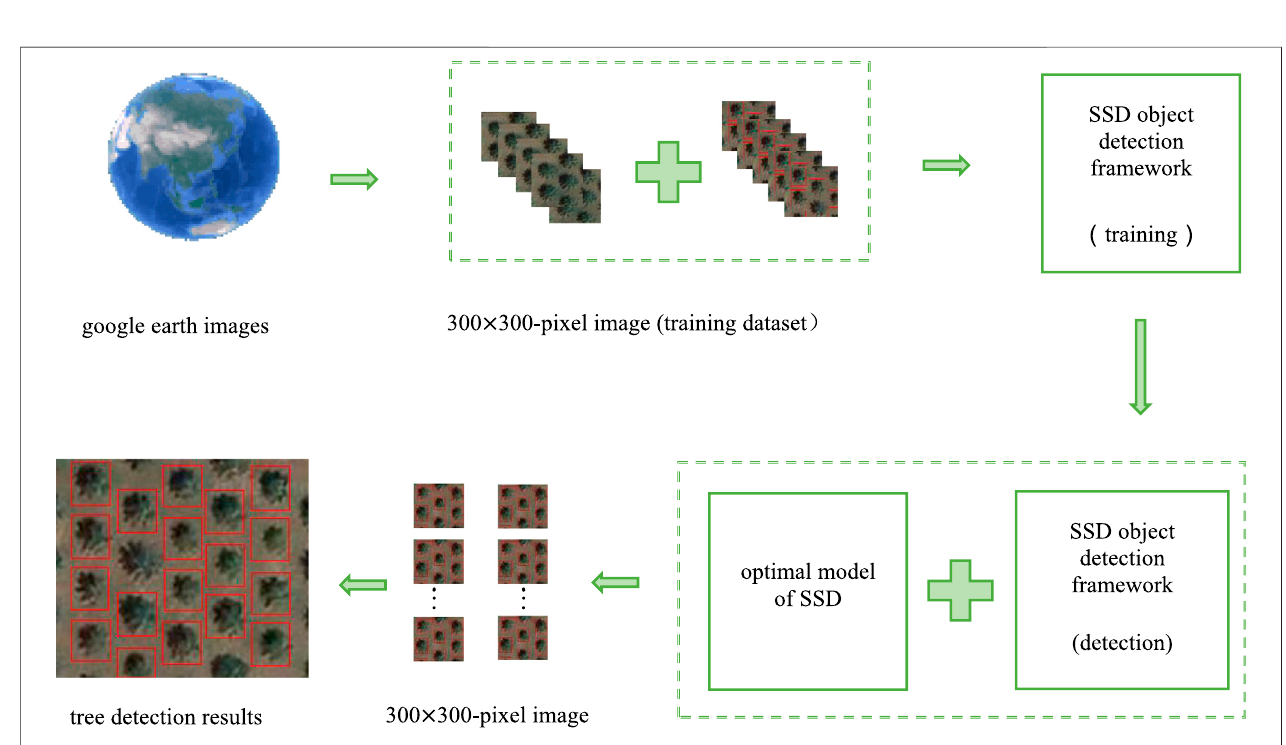
FIGURE 2 | The overall process of single tree detection based on